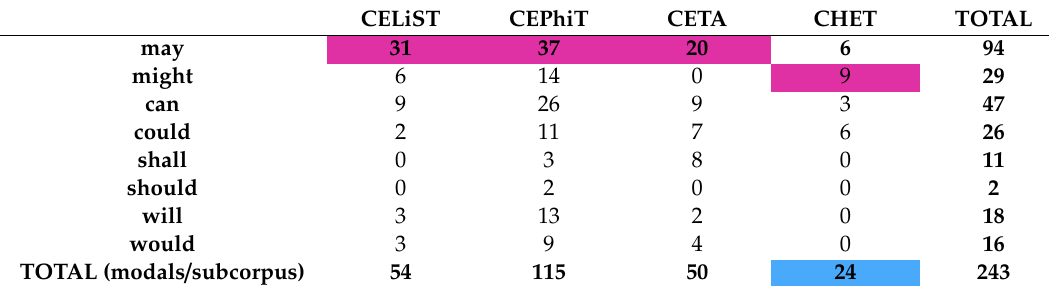
Table 4. Adverbs and accompanying modal